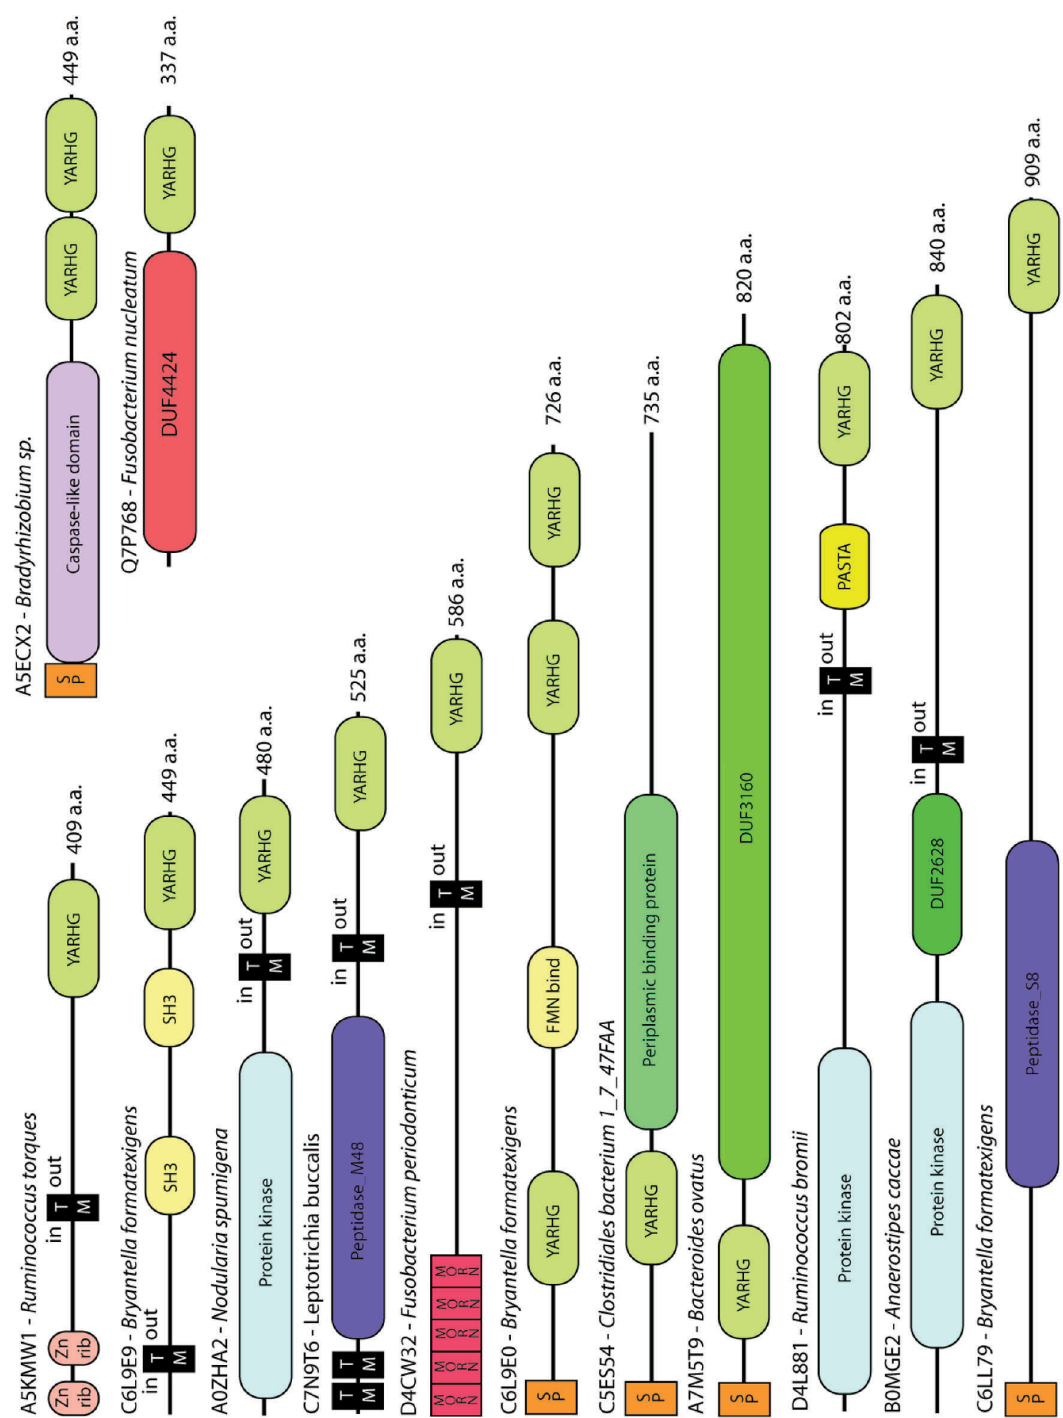
Figure 2. Representative domain-architectures of proteins containing the YARHG domain. One representative sequence-graphic for each of the 14 different combinations of domains that the YARHG domain is found with. Note that the formal name for Bryantella formatexigens is now Marvinbryantia formatexigens [25].